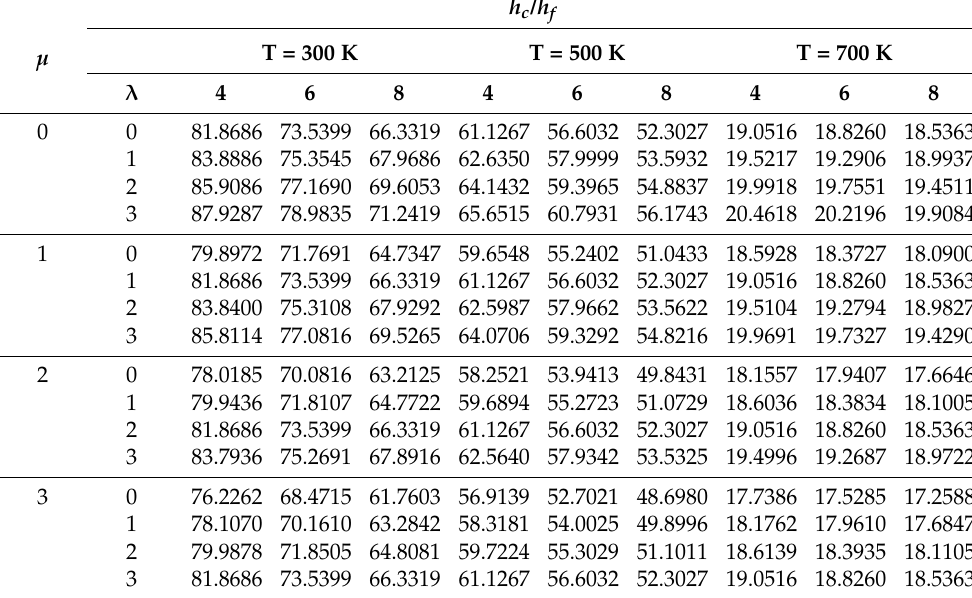
Table 7. Effect of nonlocal and length scale parameter on the dimensionless buckling load of